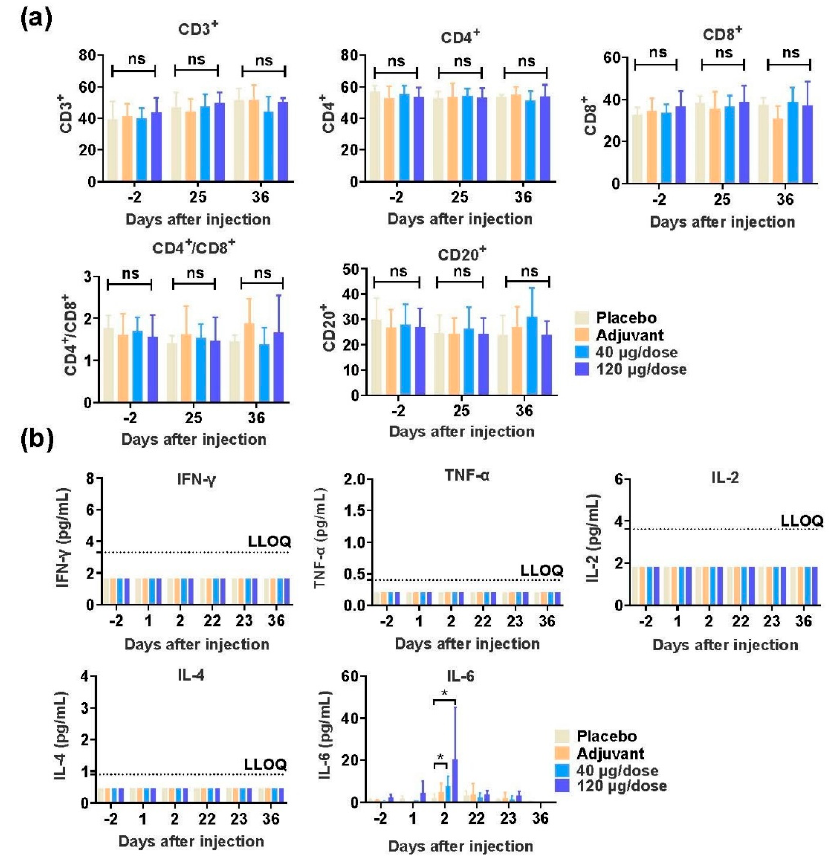
Figure 5. Safety evaluation of SCTV01A in nonhuman primates. Rhesus macaques (n = 10/group) were immunized four times at days 1, 8, 15, and 22 intramuscularly with low-dose (40 μ g) or high- dose (120 μ g) SCTV01A or adjuvant only or placebo. Hematological analysis in all four groups of macaques. ( a ) Percentage of lymphocytes, including CD3 + , CD4 + , CD8 + , CD4 + , CD8 + , and CD20 + , were monitored at days − 2 (2 days before vaccination), 25 (3 days after the third vaccination), and 36 (14 days after the third vaccination). ( ab ) Key cytokines containing IFN- γ , TNF- α , IL-2, IL-4, and IL-6 were examined at days − 2, 25, and 36 after vaccination. Statistical analyses were performed using unpaired two-tailed tests. * p < 0.05. 4. Discussion The COVID-19 pandemic caused by SARS-CoV-2 infection has led to a global health crisis. In order to prevent the transmission of SARS-CoV-2 around the world, vaccines with good efficacy and safety are urgently needed. SARS-CoV-2 infects human host cells through the binding of S proteins to cell surface-expressed ACE2 receptors [3,4]. To block virus infection, extracellular domain or the RBD of S protein is widely used as a candidate